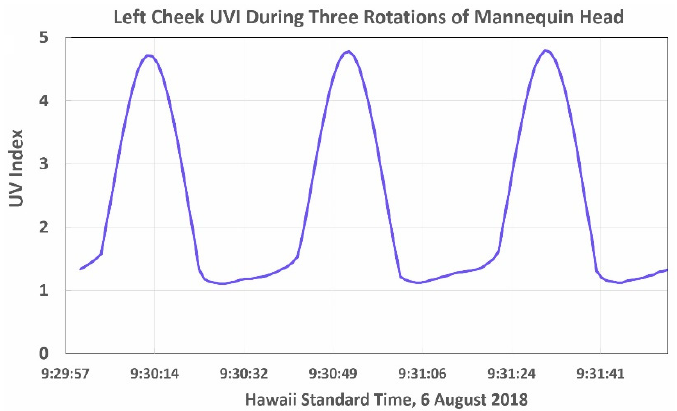
Figure 4. UVI measured by the mannequin head’s left cheek sensor during three revolutions at midmorning on 22 July 2018 at the Old Kona Airport park. Note the dramatic increase in the UVI as the cheek faces the sun’s direction.